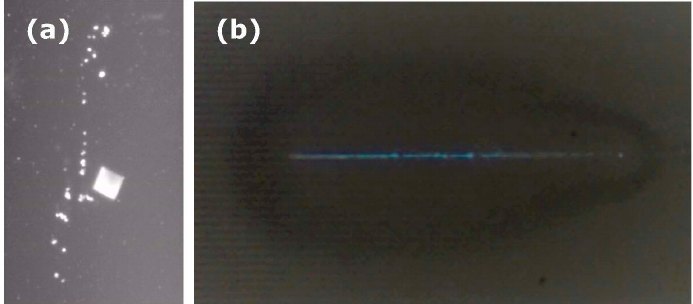
Figure 1. ( a ) KCl crystals induced by a laser pulse of 25 ps; ( b ) plasma line and shockwave preceding the nucleation phenomena, captured by an ultrafast camera with a 25 μ s shutter